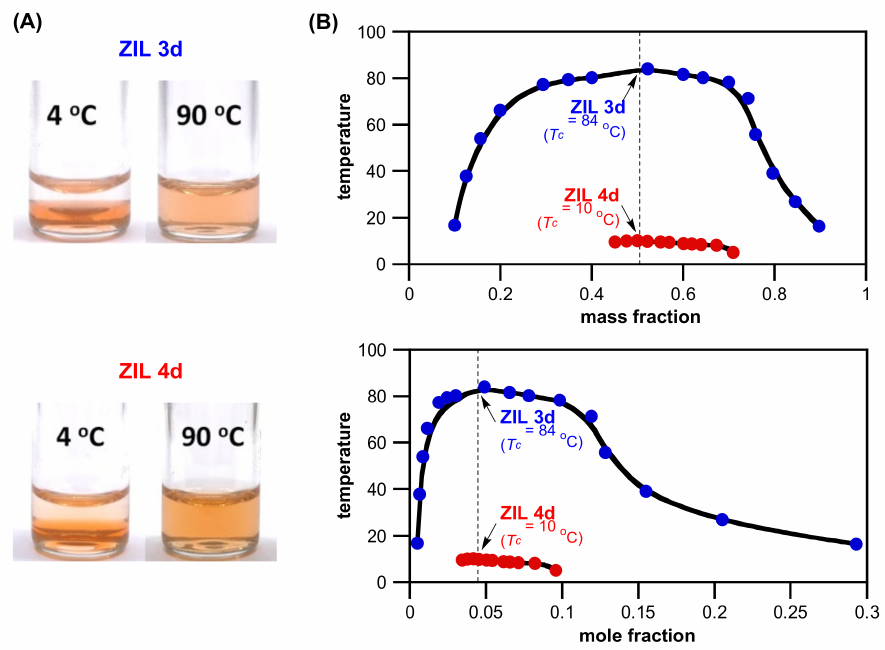
Figure 5. ( A ) Temperature-dependent phase transitions of binary mixtures (1:1, w/w ) of water with ZIL 3d ( T c = 84 ◦ C) and ZIL 4d ( T c = 10 ◦ C) at 4 ◦ C and 90 ◦ C, respectively. The Congo red dye (0.001 wt% in water) was added to make the phase boundary more noticeable. ( B ) Phase diagrams (both T c vs. mass fraction and T c vs. mole fraction) of a mixture of water with ZIL 3d and ZIL 4d , respectively. Solid lines are the guide for the